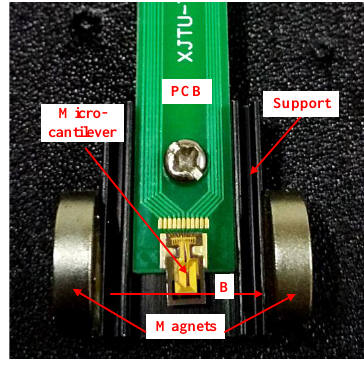
Figure 7. Schematics of different excitation methods.